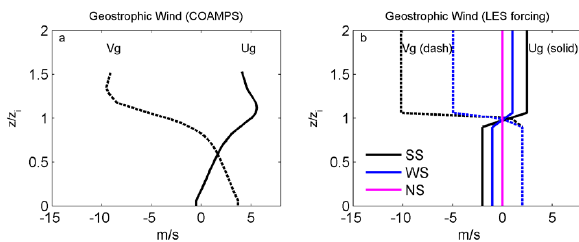
Fig. 2. Specification of geostrophic wind for LES simulations. (a) Daily averaged geostrophic winds on 13 November 2008, derived from the COAMPS regional forecast (Wang et al. 2011); and (b) specified geostrophic winds for simulations. Dashed lines denote the me- ridional components, solid the zonal components.